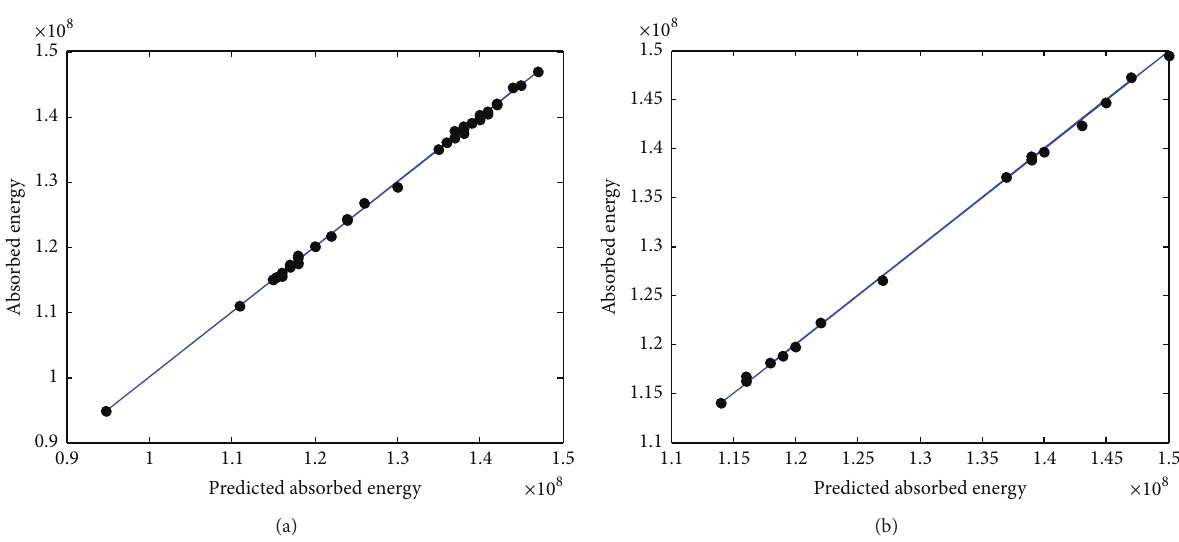
Figure 5: Regression diagrams of real and predicted results (using network) for (a) training data set and (b) testing data set: absorbed energy.